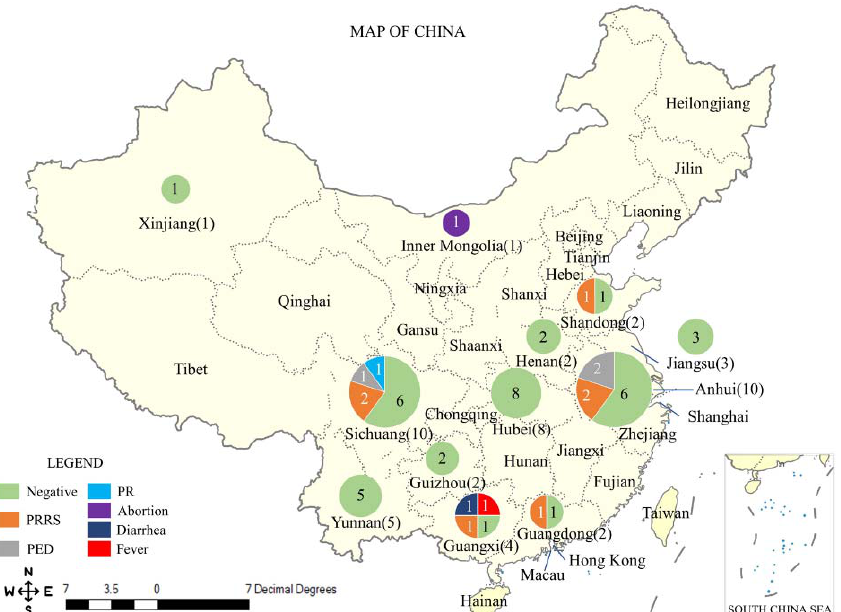
Figure 1. Geographical distribution of farms in the survey and their viral diseases status. The size of the circular chart and the number next to the province name both indicate the number of valid farms engaged in this survey. The colors on the circular charts represent the disease status of the farms, and the numbers represent how many farms have the specific disease status.